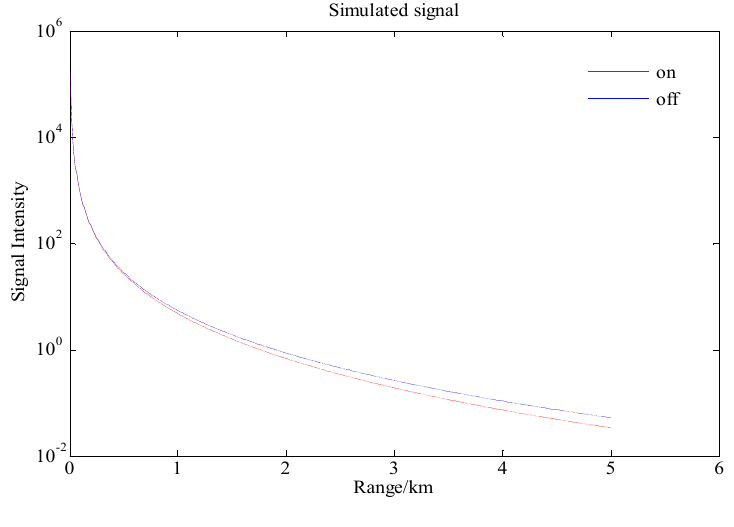
Figure 5. Simulated echo signal of DW-DIAL.